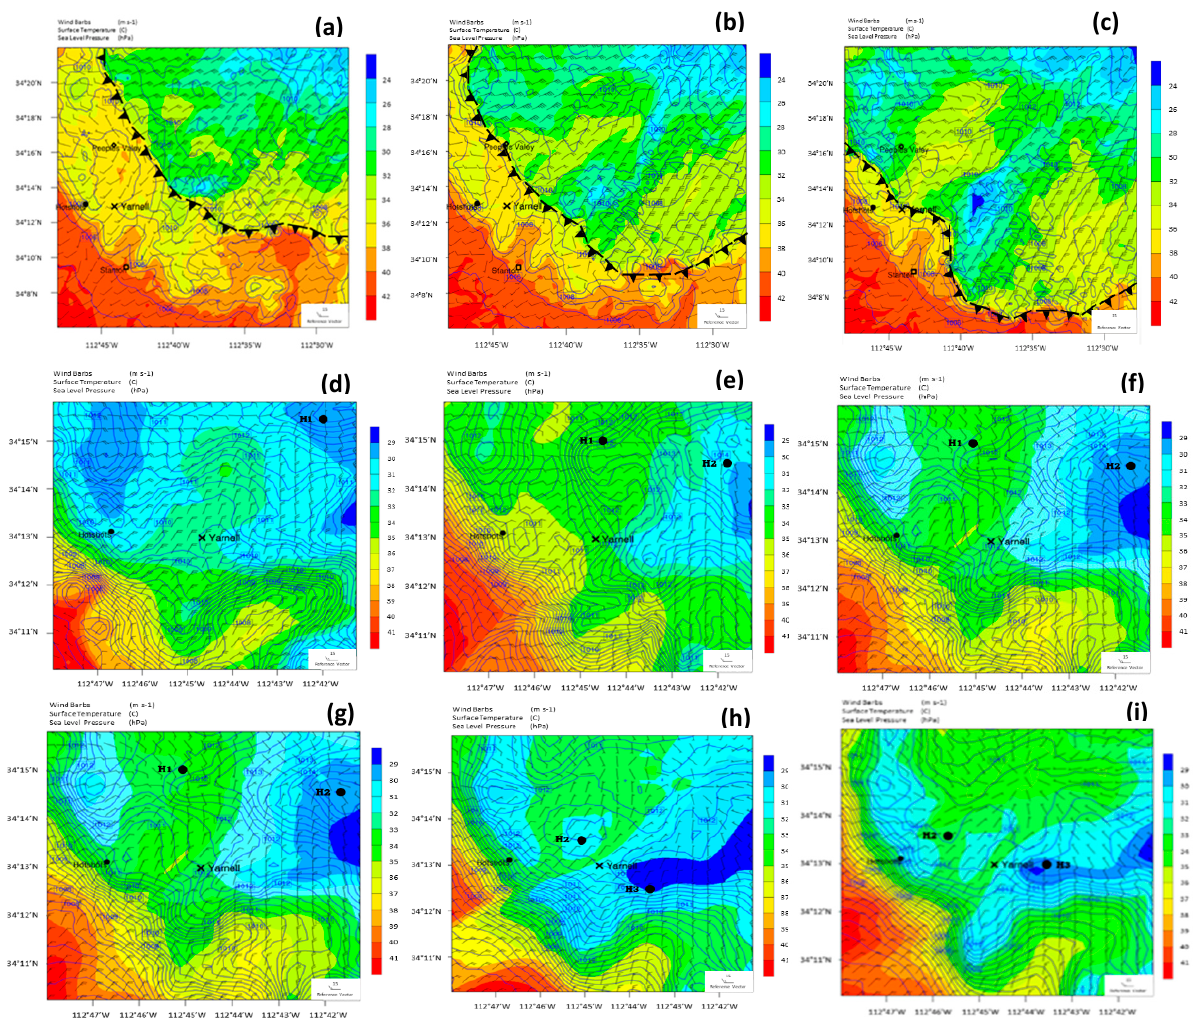
Figure 6. WRF-LES 259 m simulated 10 m wind (ms − 1 ; full barb = 10 ms − 1 ) mean sea level pressure (hPa) and temperature (°C) valid at ( a ) 2245 UTC, ( b ) 2250 UTC, ( c ) 2255 UTC, over the entire d04 grid and ( d ) 2315 UTC, ( e ) 2325 UTC, ( f ) 2335 UTC, ( g ) 2345 UTC, ( h ) 2350 UTC, and ( i ) 2355 UTC 30 June 2013 over the zoomed-in region. Density current boundary is in black cold front symbols. H denotes the meso- γ -scale high.